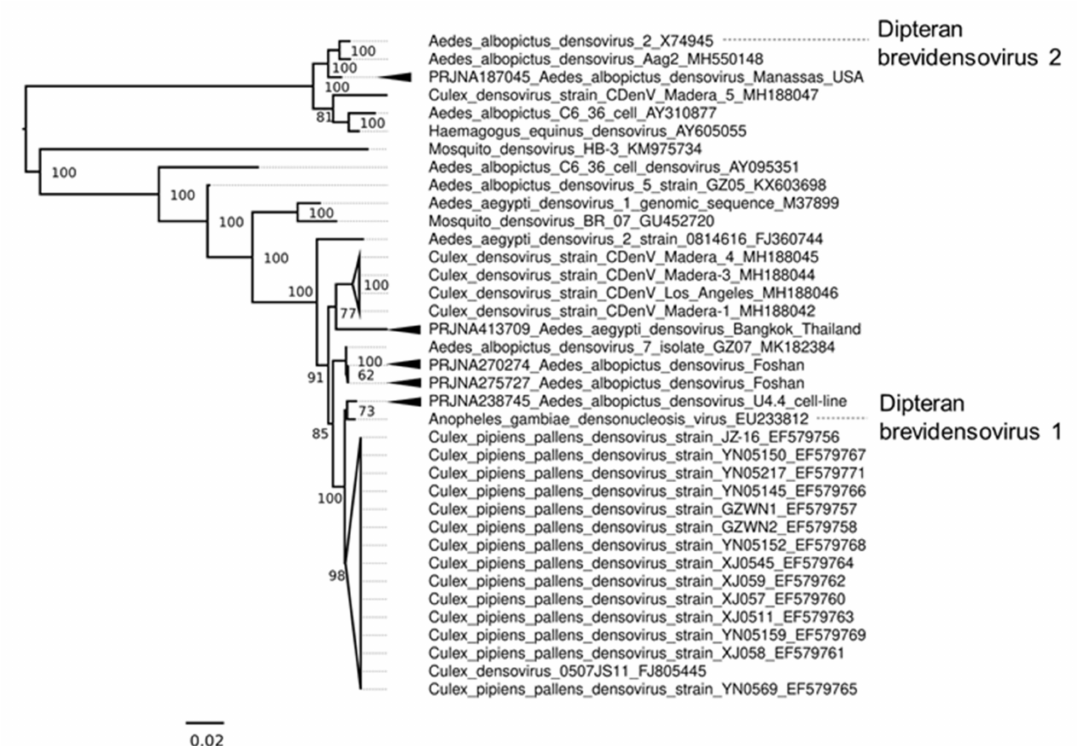
Figure 7. Phylogenetic relationship of Dipteran brevidensovirus strains identified in this study. Consensus tree constructed using NS1/NS2 and VP whole coding regions of virus genomes aligned using MAFFT. Ambiguous alignment regions were removed using GBLOCKS. Consensus maximum-likelihood trees were constructed with IQTree under the TIM2 + F+G4 nucleotide substitution model with 50,000 Ultrafast bootstraps. Bootstrapping support was conducted using 10,000 ultrafast bootstraps. Culex pipiens pallens densovirus and Culex densovirus nodes were collapsed for simplicity. The tree is midpoint rooted, and Genbank numbers corresponding to published virus strains are indicated on the label; novel strains of mosquito brevidensovirus are marked with arrowheads, along with the BioProject accession